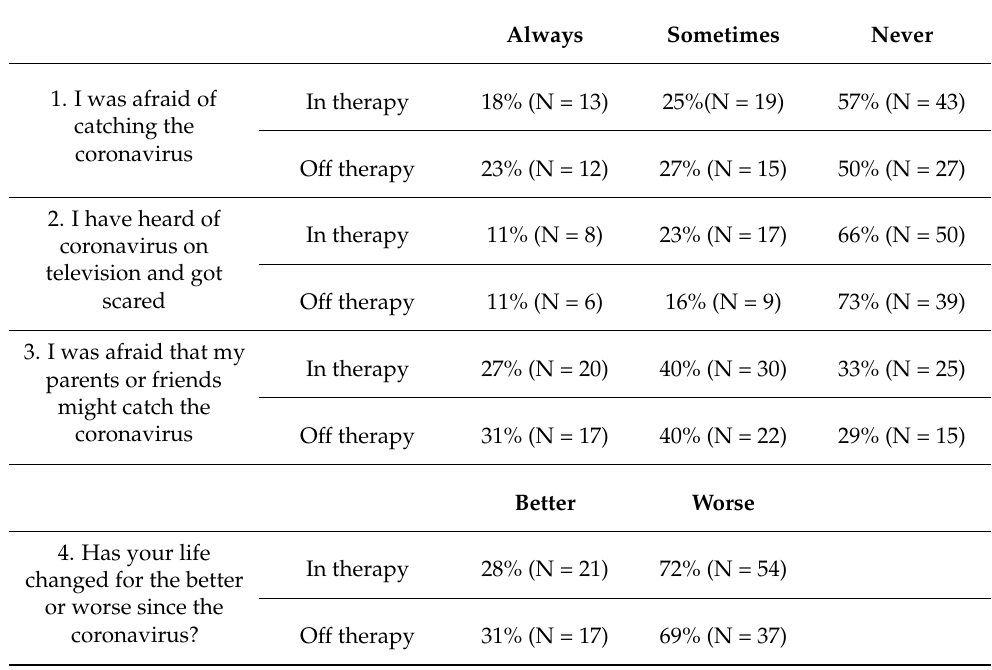
Table 4. Emotional experience and feelings towards pandemic within fragile group (active and no active treatment) (n = 129).